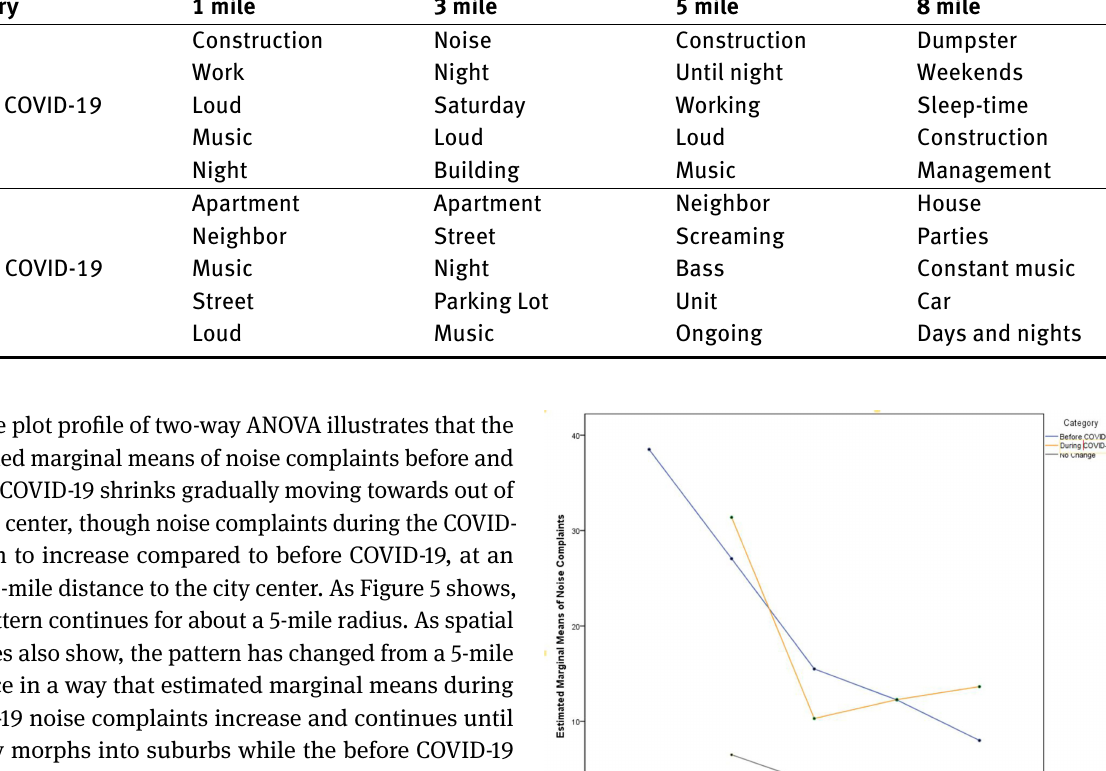
Figure 4: Number of noise complaints and majority census tracts comparisons with the proximity of city center Table 3: Word frequency of noise complaints in each buffer zone Category